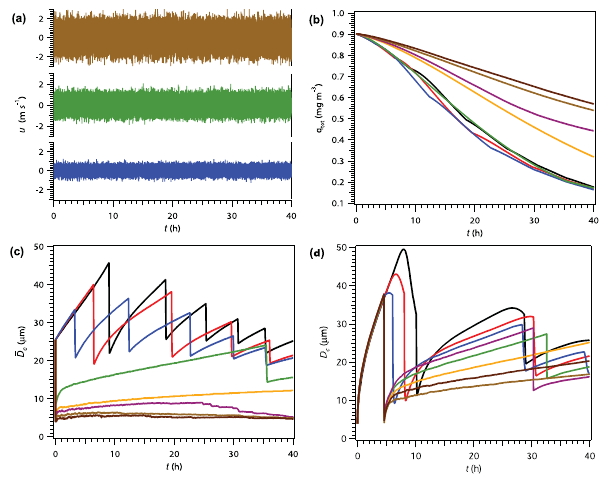
Fig. 5. Time series of (a) updraft velocity, u , (b) total water con- tent, q tot , and ¯ D c (c) mean ice crystal diameter, ¯ D c , for the condi- tions presented in Fig. 4; (d) time series of ¯ D c for initial S and N c of − 0.2 and 0, respectively, and homogeneous and heterogeneous nucleation active (conditions similar to Fig.